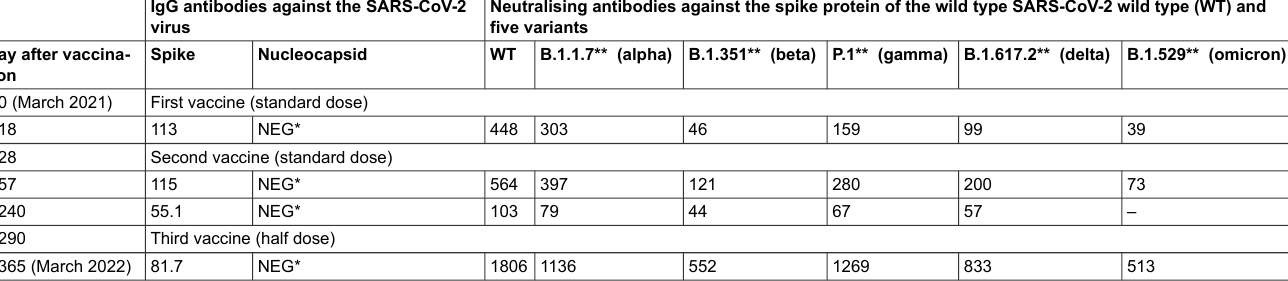
Table 1: IgG antibodies directed against the spike protein (S) or the nucleocapsid protein (N) of the SARS-CoV-2 virus, assessed using a Luminex ® assay (10) and neutralising antibod- ies towards the spike protein of the wild type virus and of various SARS-CoV-2 variants. Note the expected high titres of anti-S antibodies and heterogeneously high titres of neutralising antibodies after SARS-CoV-2 vaccination. These neutralising antibodies appear, however, to exhibit reduced efficacy on variant B.1.529** (omicron) and B.1.351** (beta), as expected owing to several mutations in the spike protein, including the E484K mutation. IgG antibodies against the SARS-CoV-2 Neutralising antibodies against the spike protein of the wild type SARS-CoV-2 wild type (WT) and virus five variants Day after vaccina- tion